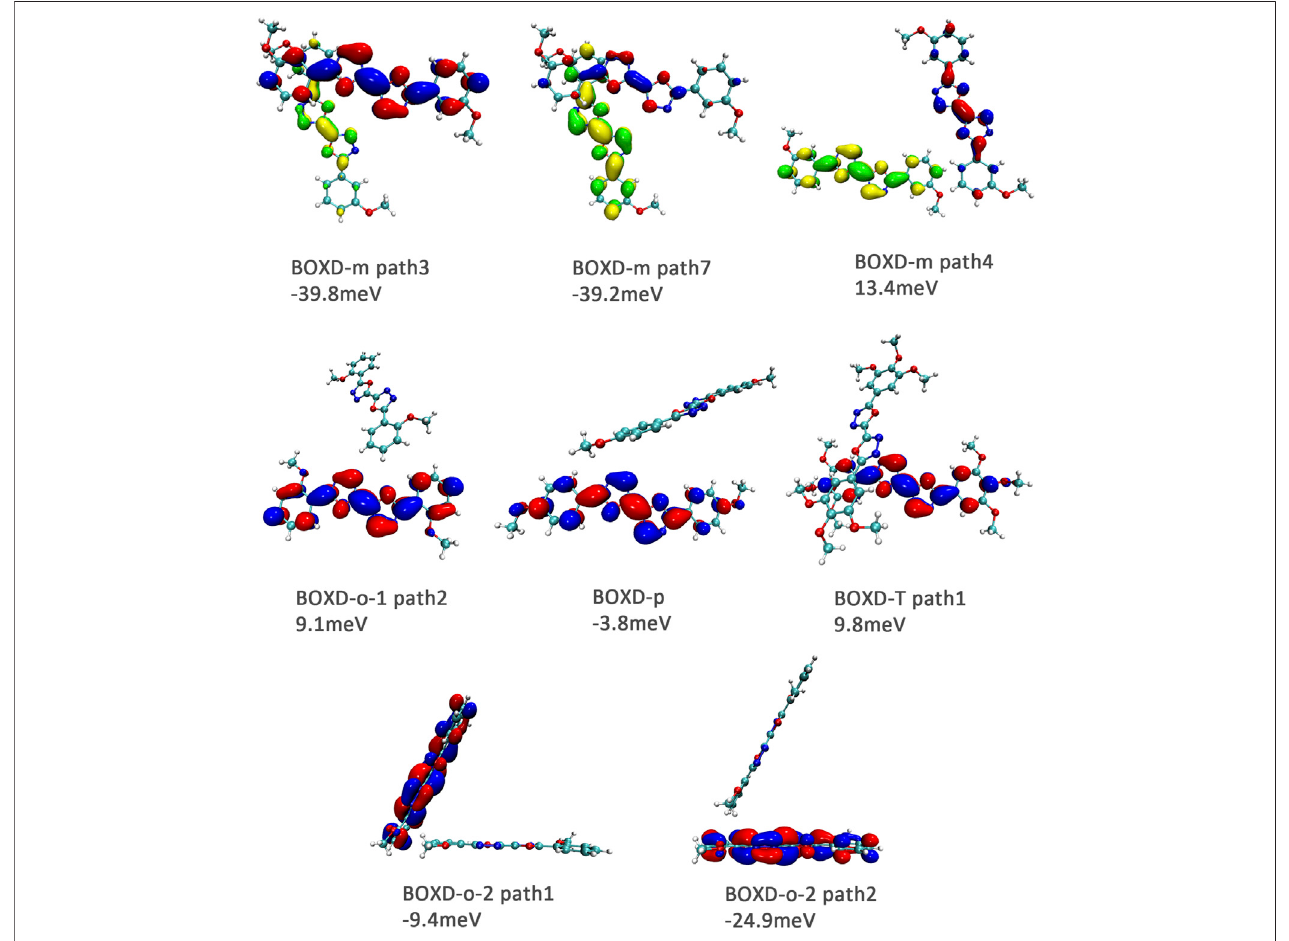
FIGURE6| Bimolecularorbitaldistributionofprimaryelectron transferpathsinherringbonearrangement.Thepositivephaseisdepictedinred andyellow,andthe negative phase is depicted in blue and green.